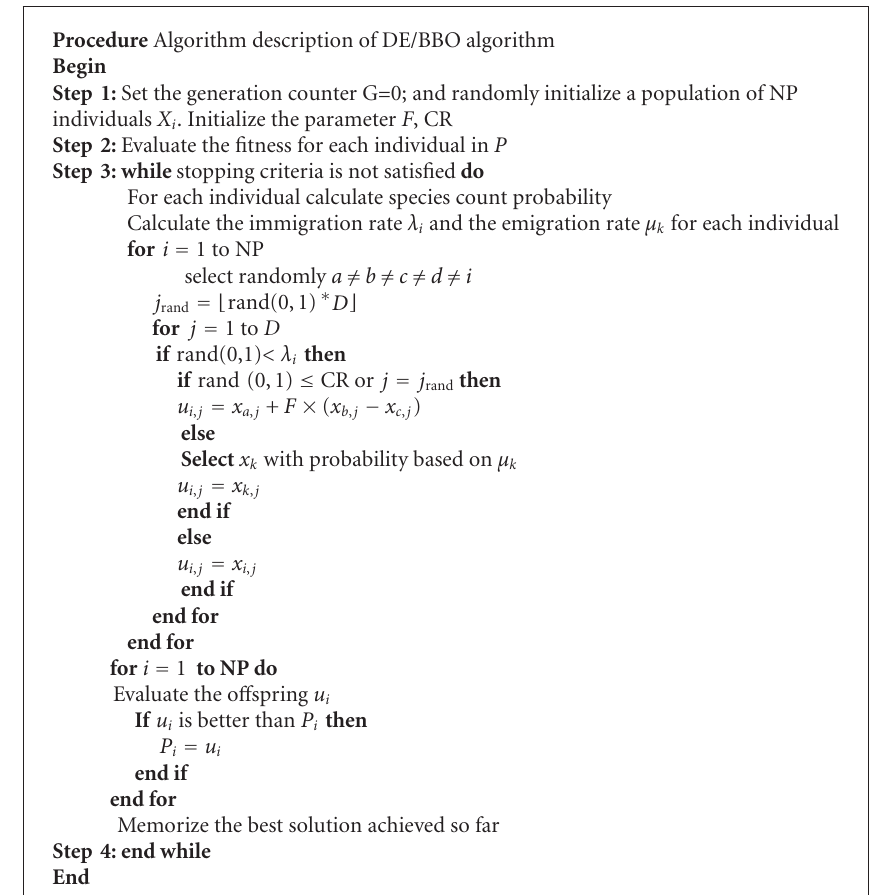
Procedure Algorithm description of DE/BBO algorithm